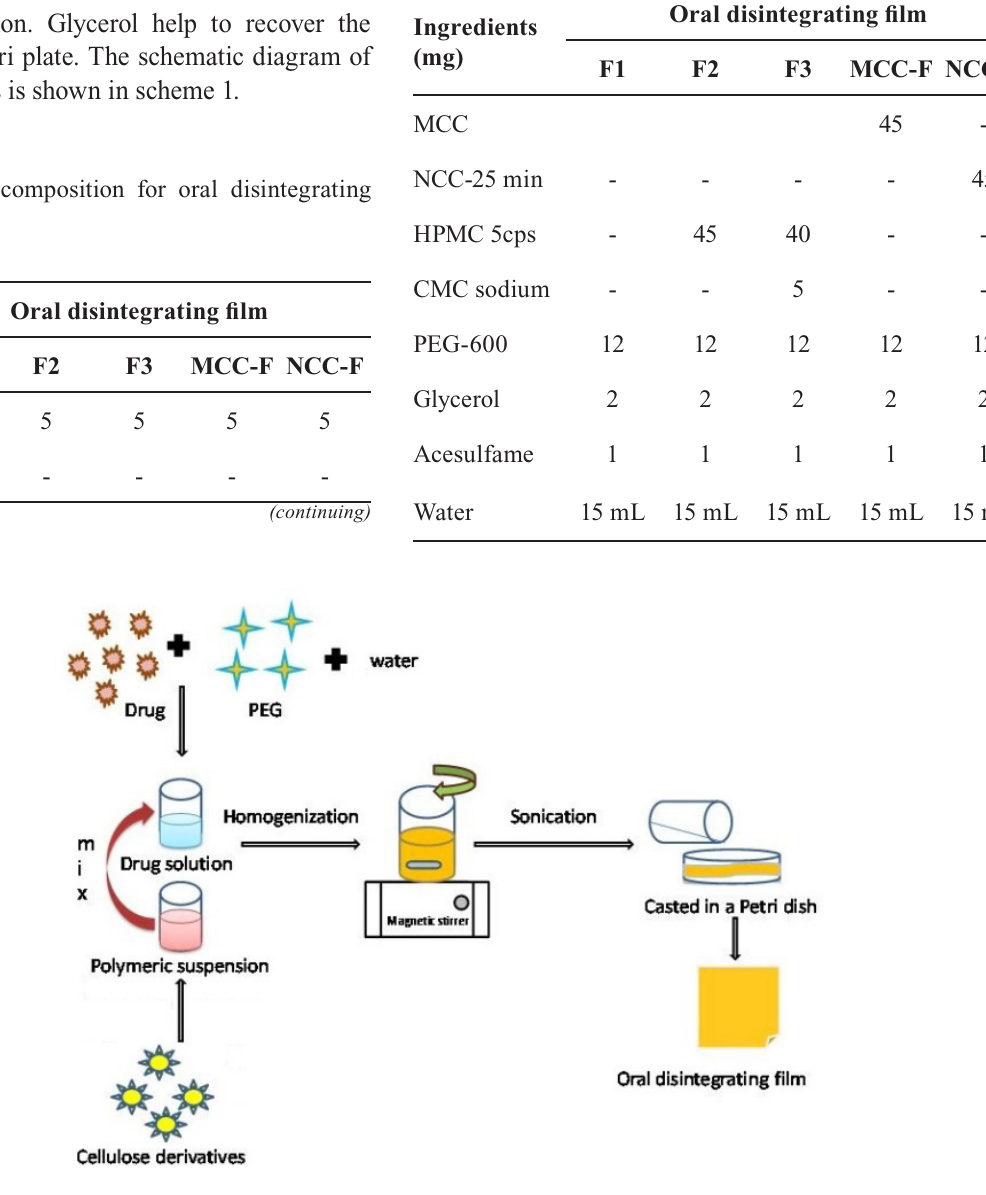
SCHEME 1 - Schematic representation about the preparation of cellulose based